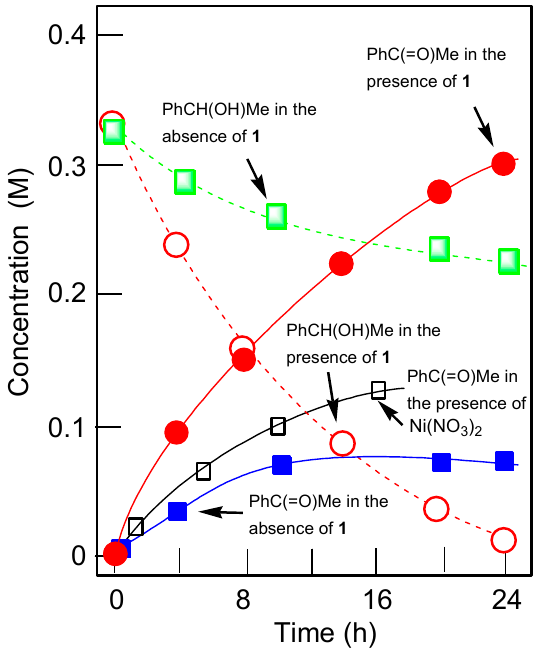
Figure 4. Formation of acetophenone with time in the 1-phenylethanol (0.33 M) oxidation with tert -butyl hydroperoxide (TBHP; 70%, aqueous, 1.65 M) in the absence and in the presence of compound 1 (5 × 10 − 4 M), as well as in the presence of Ni(NO 3 ) 2 . Solvent was acetonitrile (total volume of the reaction solution was 5 mL); temperature was 70 °C.